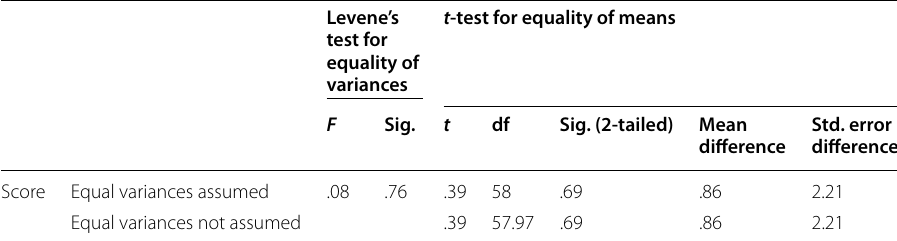
Table 17 Inferential statistics (anxiety pre‑test of both groups)